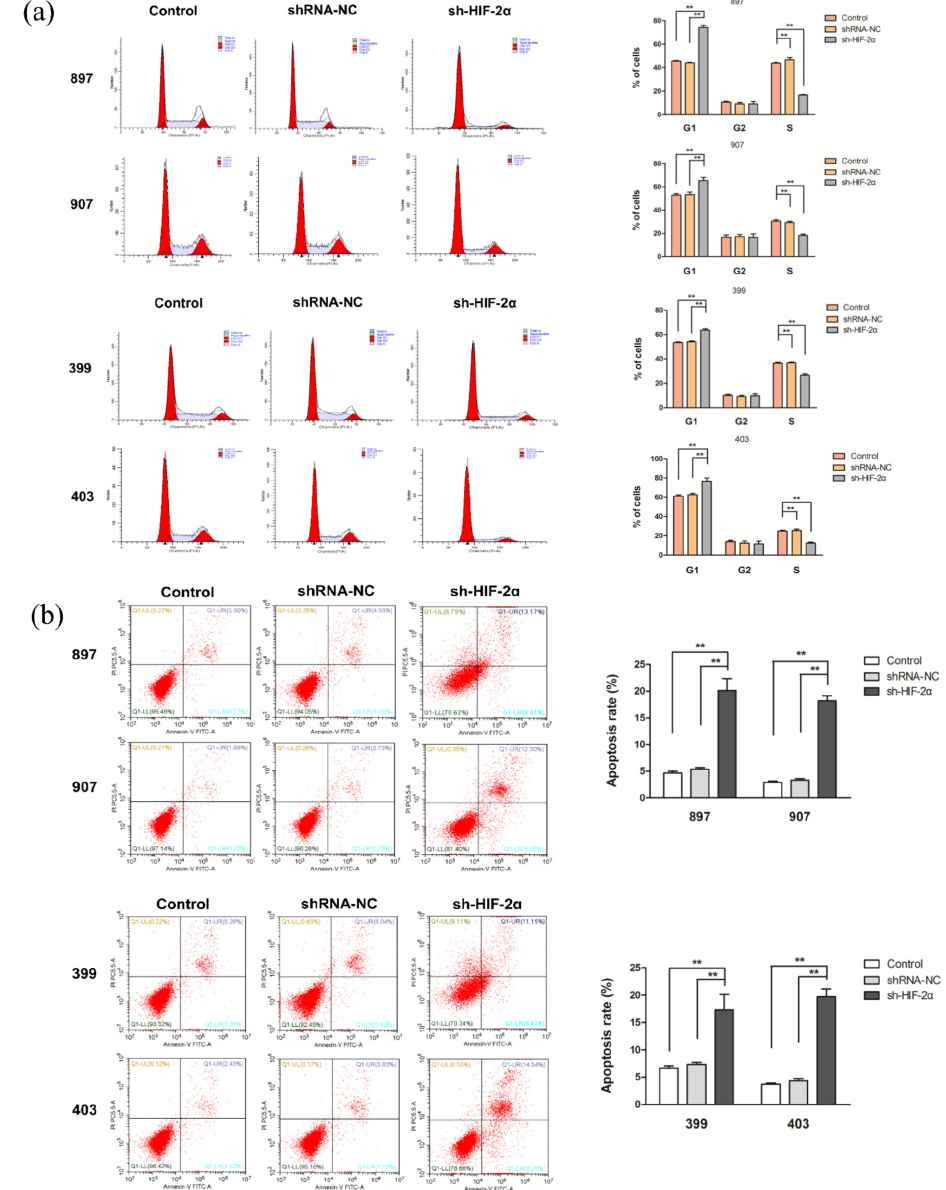
Figure 6. HIF-2 α knockdown inhibits cell cycle progression and stimulates Kras G12D and Kras G12D - LOH PDAC cell apoptosis. Kras G12D and Kras G12D -LOH PDAC cells were transfected with sh-HIF-2 α and shRNA-NC. ( a ) Cell cycle distribution of Kras G12D and Kras G12D -LOH cells. ( b ) Apoptosis rate of Kras G12D and Kras G12D -LOH cells. Data are expressed as the mean ± SD, based on three independent experiments. ** p < 0.01.